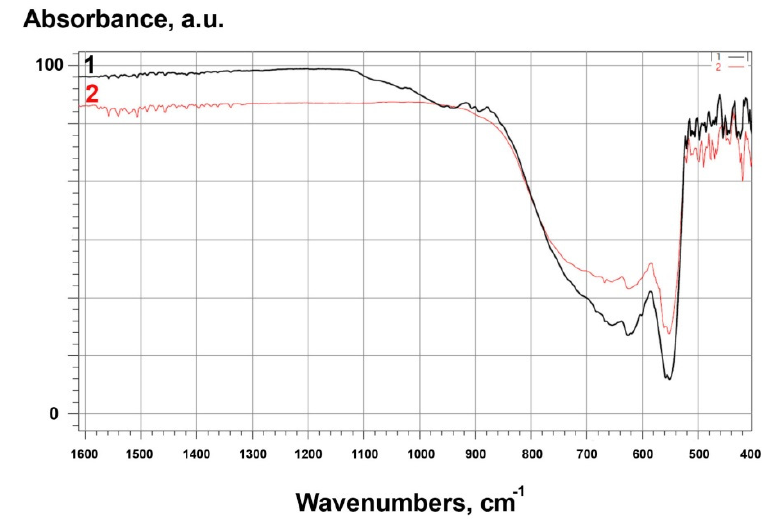
Figure 6. FTIR spectra for: 1-Al 2 O 3 _2 (modified), 2-Al 2 O 3 _1 (raw).